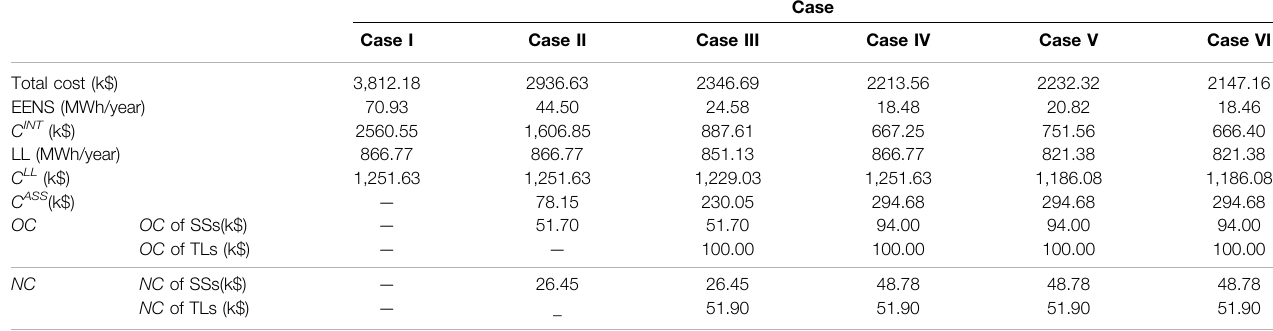
TABLE 8 | Cost of solutions of bus 2 for the six cases.